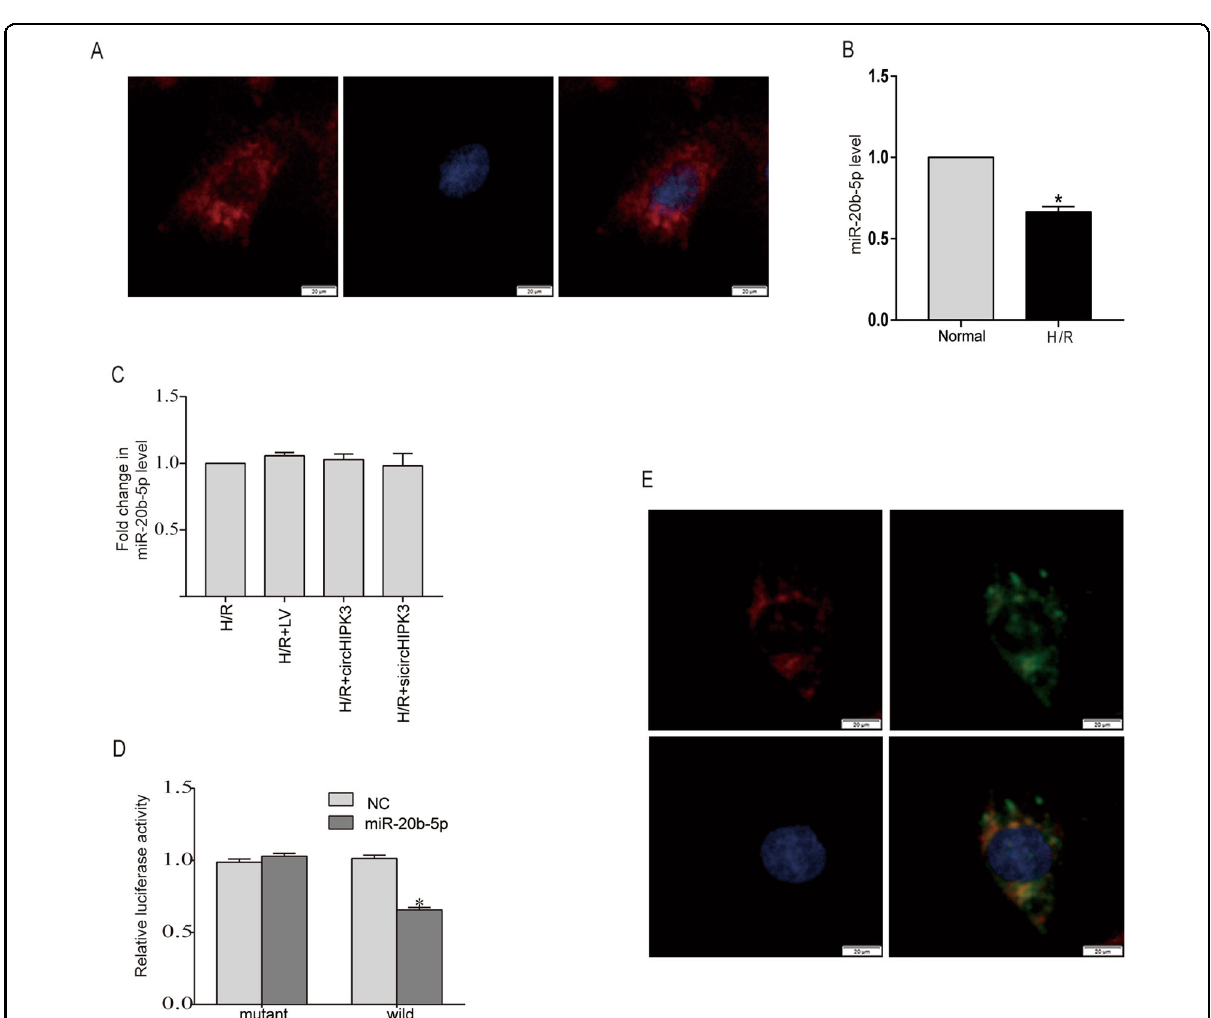
Fig. 3 CircHIPK3 acts as a miR-20b-5p sponge. A The localization of circHIPK3 was observed in cardiomyocytes by RNA FISH with a Cy3-labeled circHIPK3 probe. The nuclei were stained with DAPI. Scale bar = 20 μ m. B The expression of miR-20b-5p in normal and H/R cardiomyocytes was detected by qRT-PCR. * P < 0.05 compared with the normal group. n = 9. C qRT-PCR analysis of miR-20b-5p expression in cardiomyocytes after cardiomyocytes were transfected with negative control (LV), circHIPK3 overexpression vector, or circHIPK3 siRNA (si-circHIPK3). D The relative luciferase activities were measured in 293T cells cotransfected with circHIPK3-WT or circHIPK3-Mut and miR-20b-5p mimics or miR-NC(MNC) by luciferase reporter assay. * P < 0.05 compared with the circHIPK3-Mut group. E FISH for circHIPK3 (red) and miR-20b-5p (green) was performed in cardiomyocytes. Scale bar = 20 μ